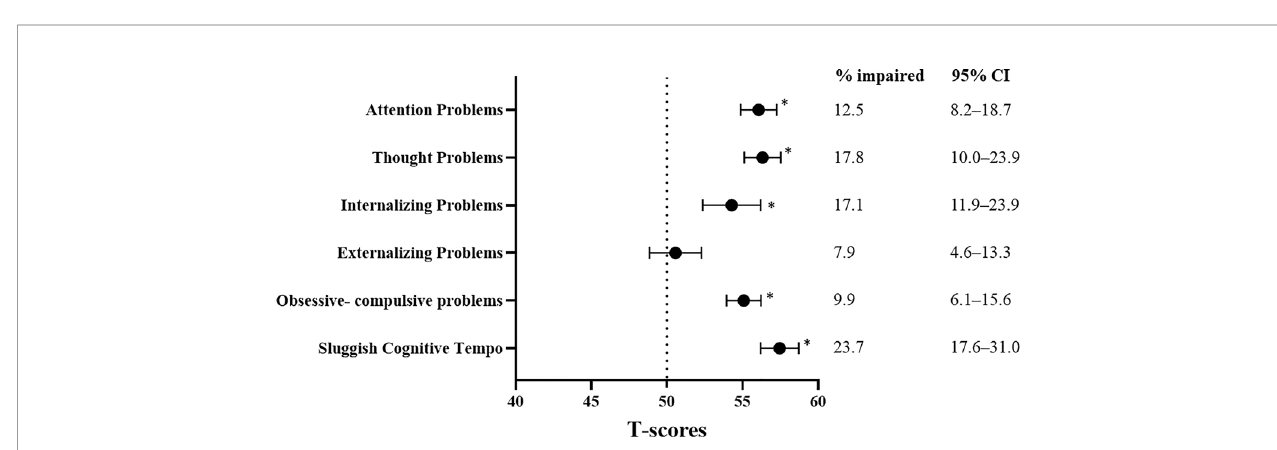
FIGURE 2 | Behavioral Outcomes and Prevalence Rates of Impairment. CI, con fi dence interval; SD, standard deviation. All behavioral measures were transformed into age-adjusted T -scores (mean = 50; standard deviation [SD] = 10) using references provided by the test manuals or the published literature ( Supplement 1 ). All T -scores were scaled such that a higher score was indicative of more problems. A one-sample t test was used to compare the survivors ’ performance with population norms (Dotted line: T -score = 50). * indicates statistical signi fi cance at P ≦ 0.01 after correcting for false discovery rate. To estimate the prevalence of impairments within the study sample, impairment was de fi ned as a score below the 1.5 standard deviation poorer than the age-adjusted T -scores of reference norms. Prevalence estimates are expressed as proportion (%) and 95% con fi dence